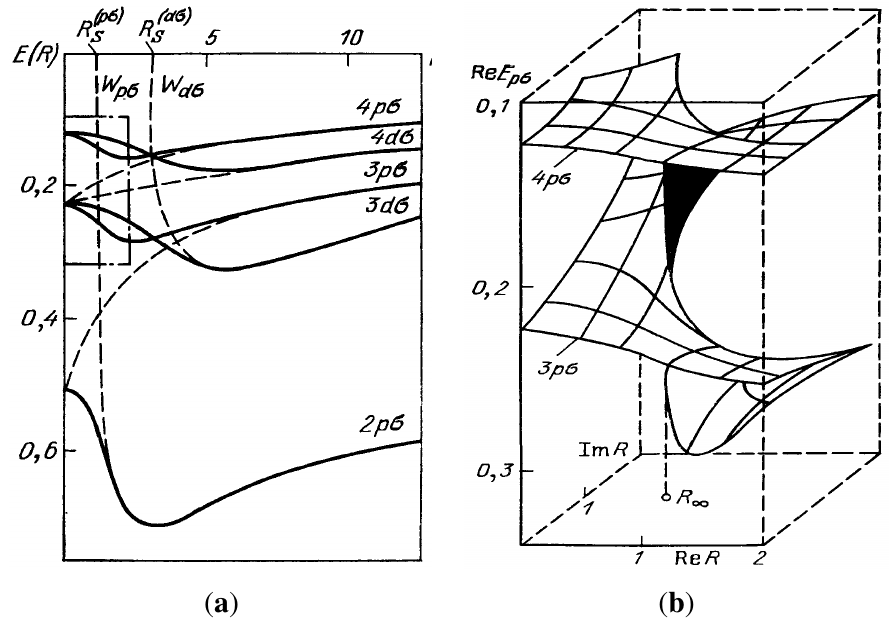
quasi-molecule. Dashed 2 , W of inelastic transitions, where p, d,  p  d